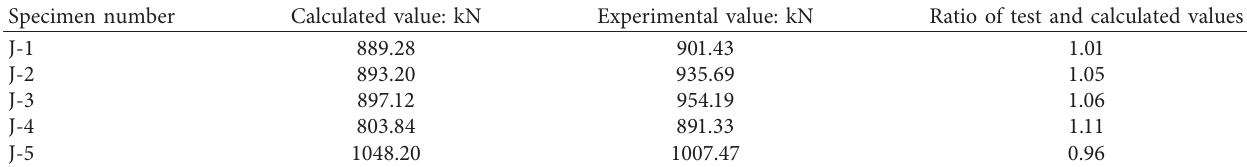
Figure 22: Concrete bearing capacity contribution fitting diagram. Table 10: Comparison of test and calculation values of shear